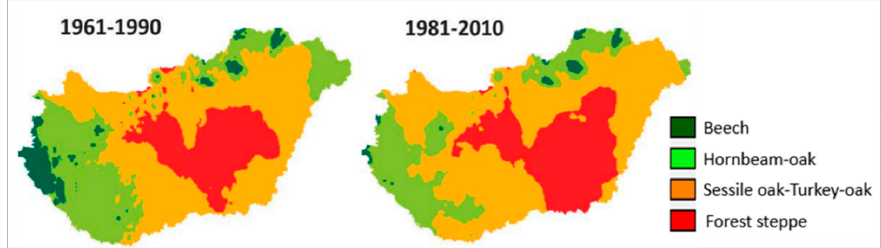
Figure 2. Recent shift of macroclimate classes in Hungary, defined by the Forestry Aridity Index (original by B. Gálos, see also [40]). For explanations see text and Appendix A.2.